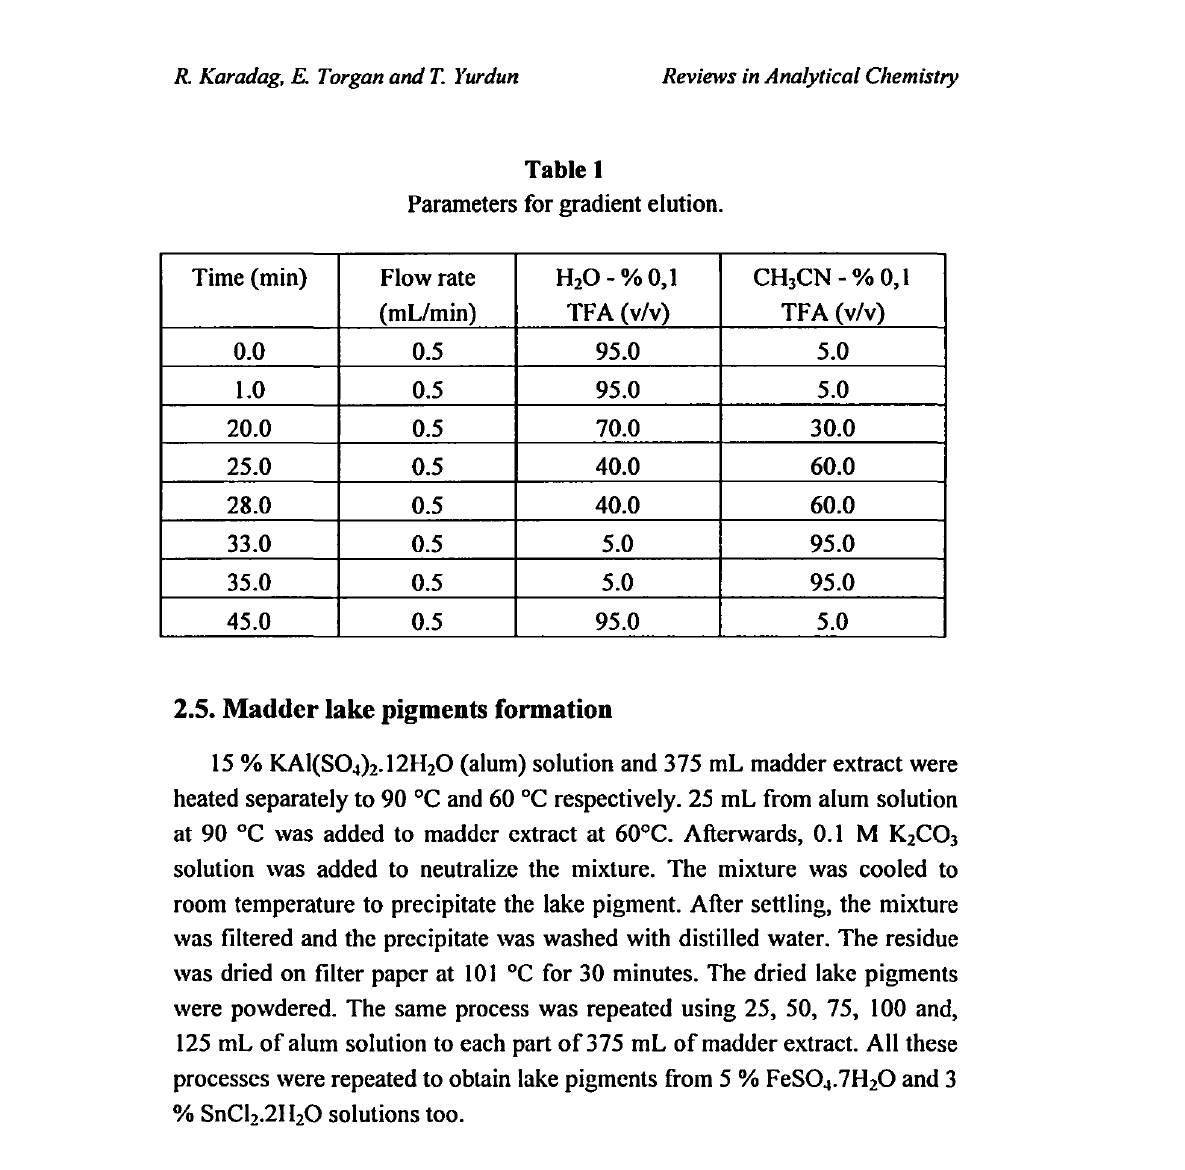
Parameters for gradient